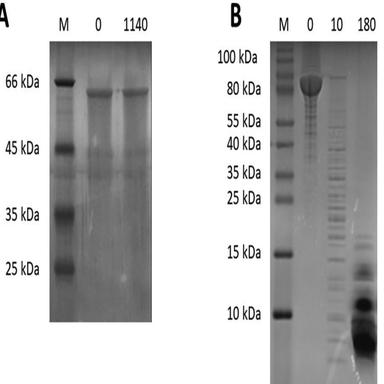
SDS-PAGE analysis of the ELR proteolysis of recombinant biopolymers showing the digested fragments obtained at different incubation times at 37 °C. Panel A: Glycine SDS-PAGE (12%) of IK-ELR (0 and 19 h). Panel B: Tricine SDS-PAGE (16%) of REDV-ELR. The numbers above the lanes refer to the incubation times in minutes. The position and size (kDa) of molecular weight protein markers are indicated with numbers at the side of the images.